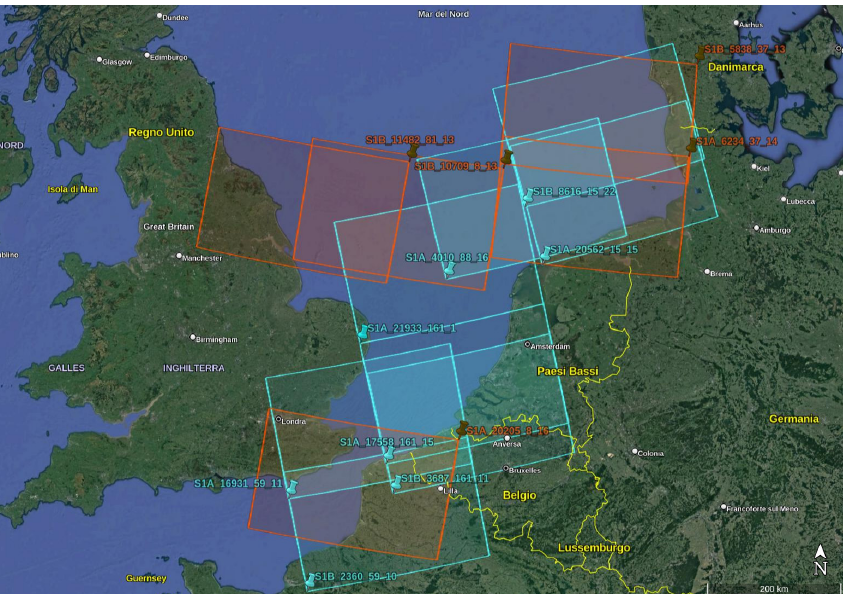
Figure 1. Atlantic European northwest shelf. Full-frame coverage is in orange and cyan for descending and ascending Sentinel-1 (S-1) Interferometric Wide Swath Ground Range Multi-Look Detected High-Resolution (IW) images, respectively. Background image (Data SIO, NOAA, US Navy, NGA, GEBCO; Image Landsat/Copernicus) is from Google